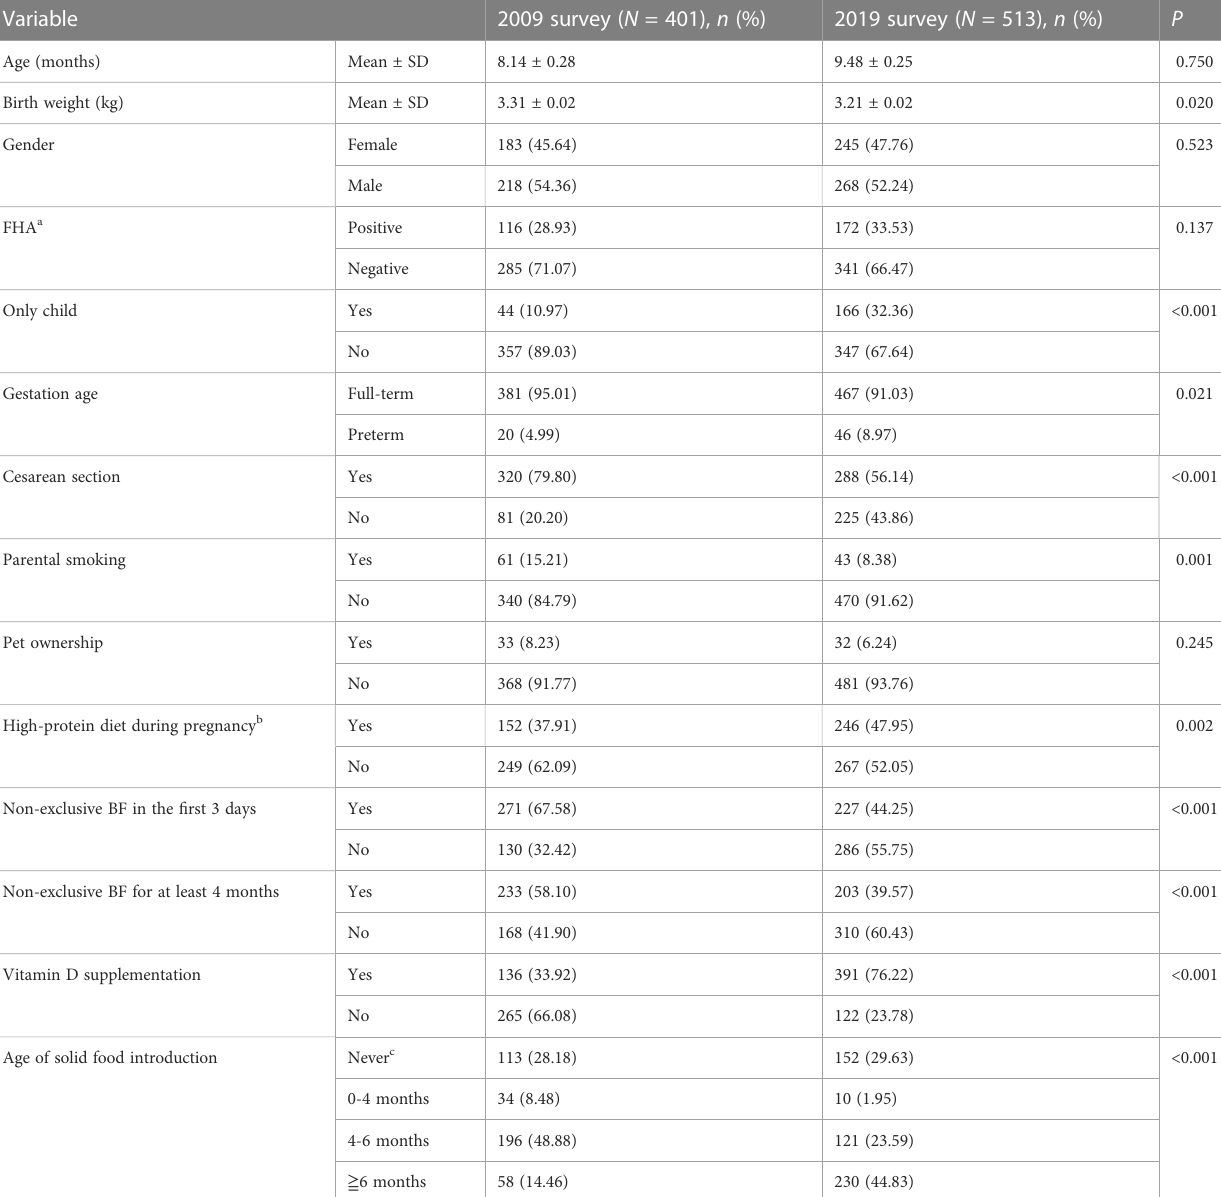
TABLE 1 Distribution of risk factors in children between the 2009 and 2019